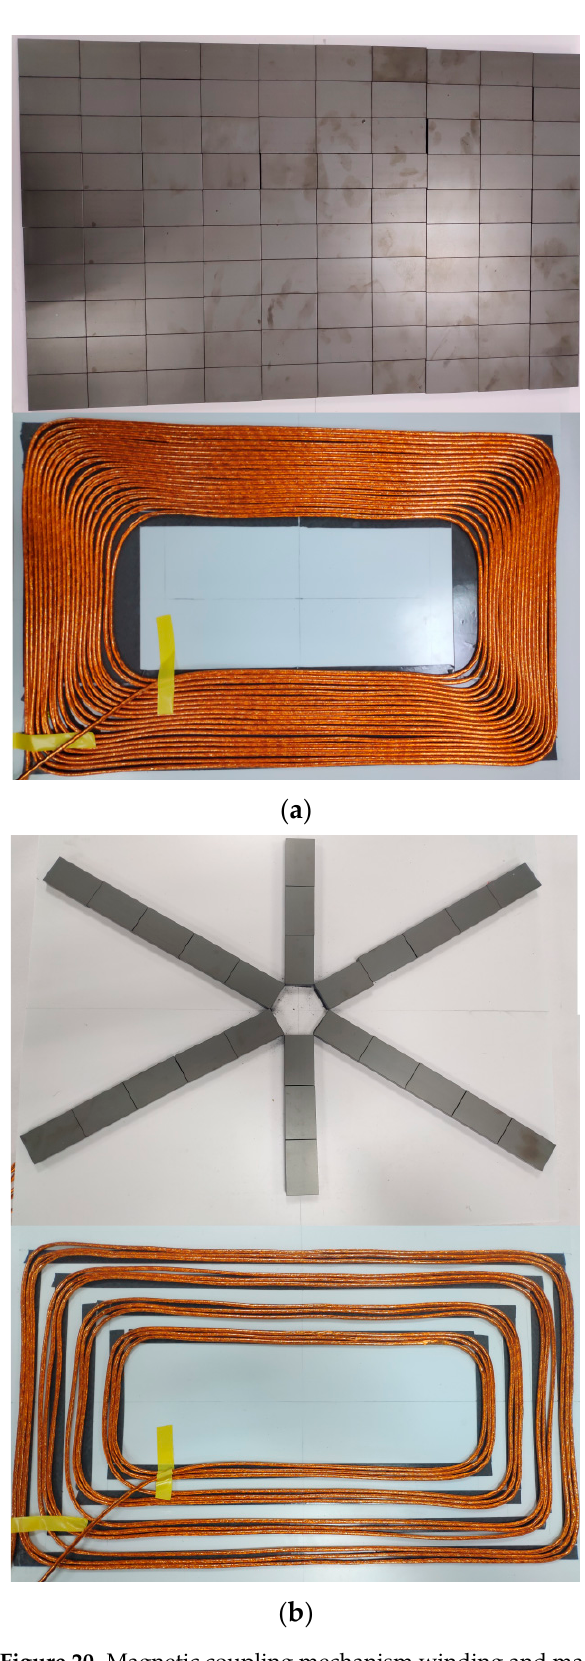
Figure 20. Magnetic coupling mechanism winding and magnetic core distribution: ( a ) primary coil and core distribution, ( b ) secondary coil and core